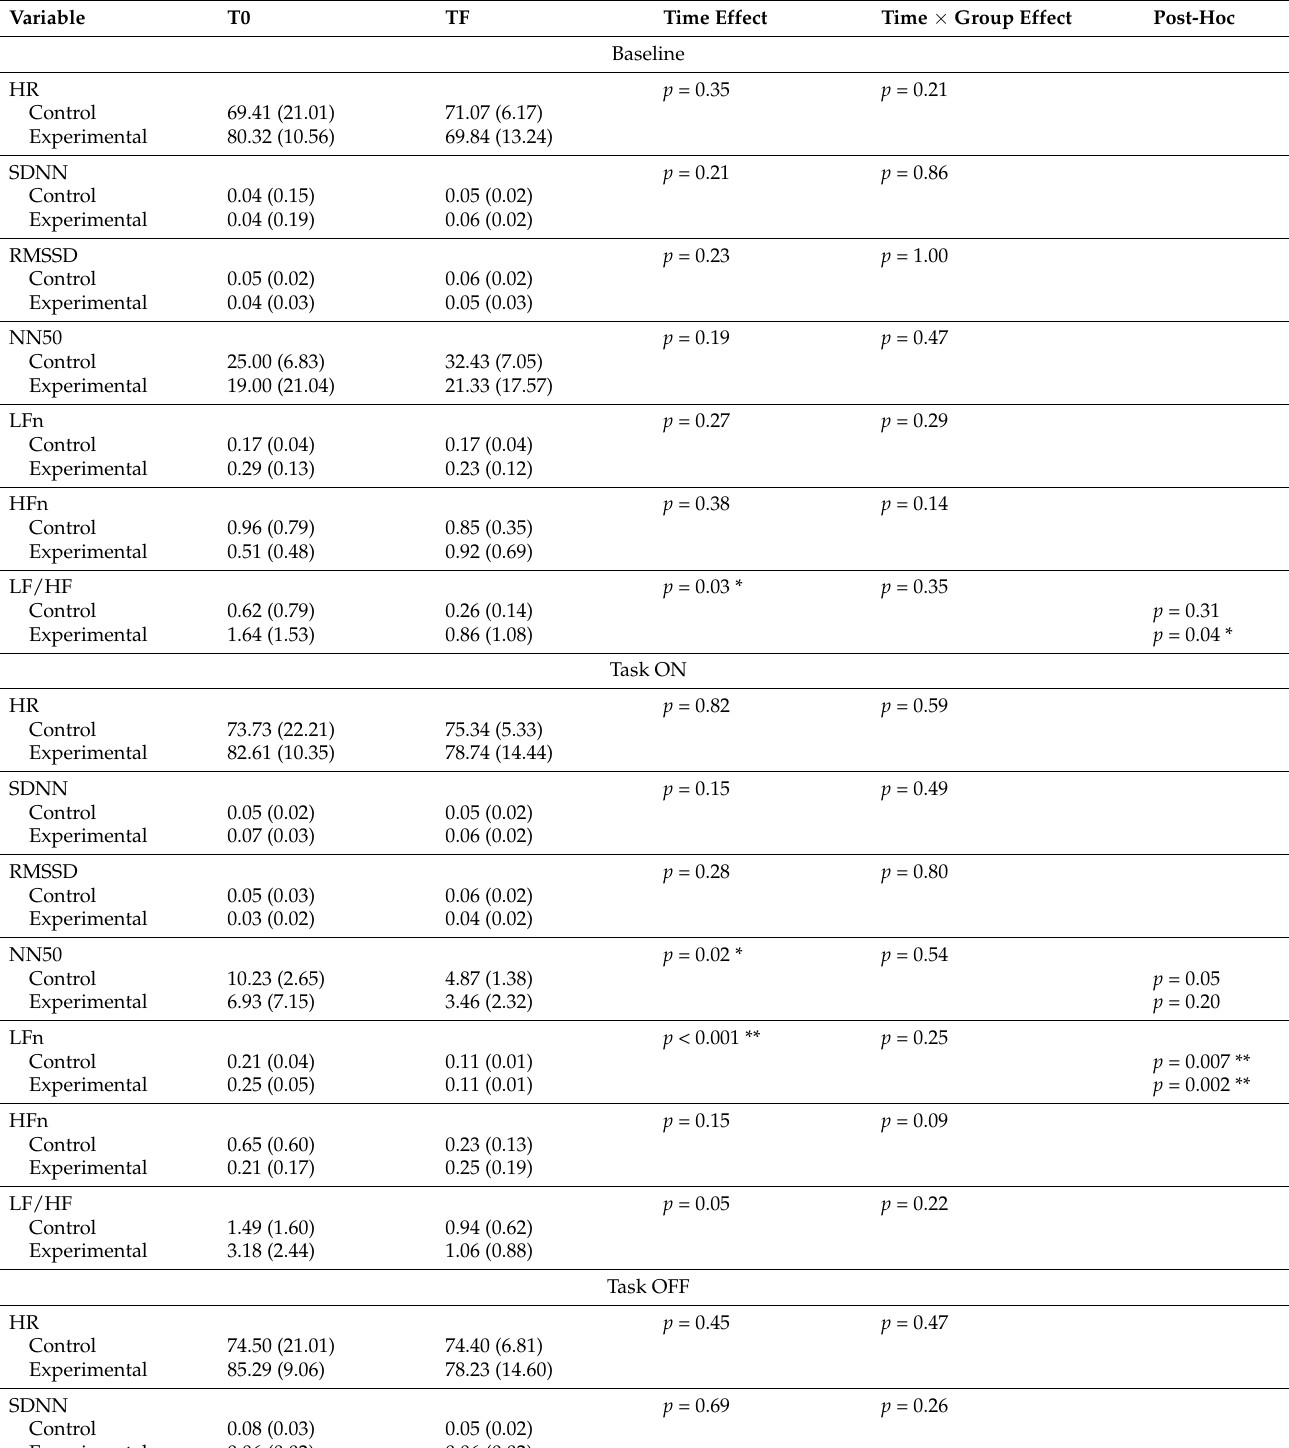
Table 3. Difference in cardiac variables from T0 to TF in control and experimental groups.